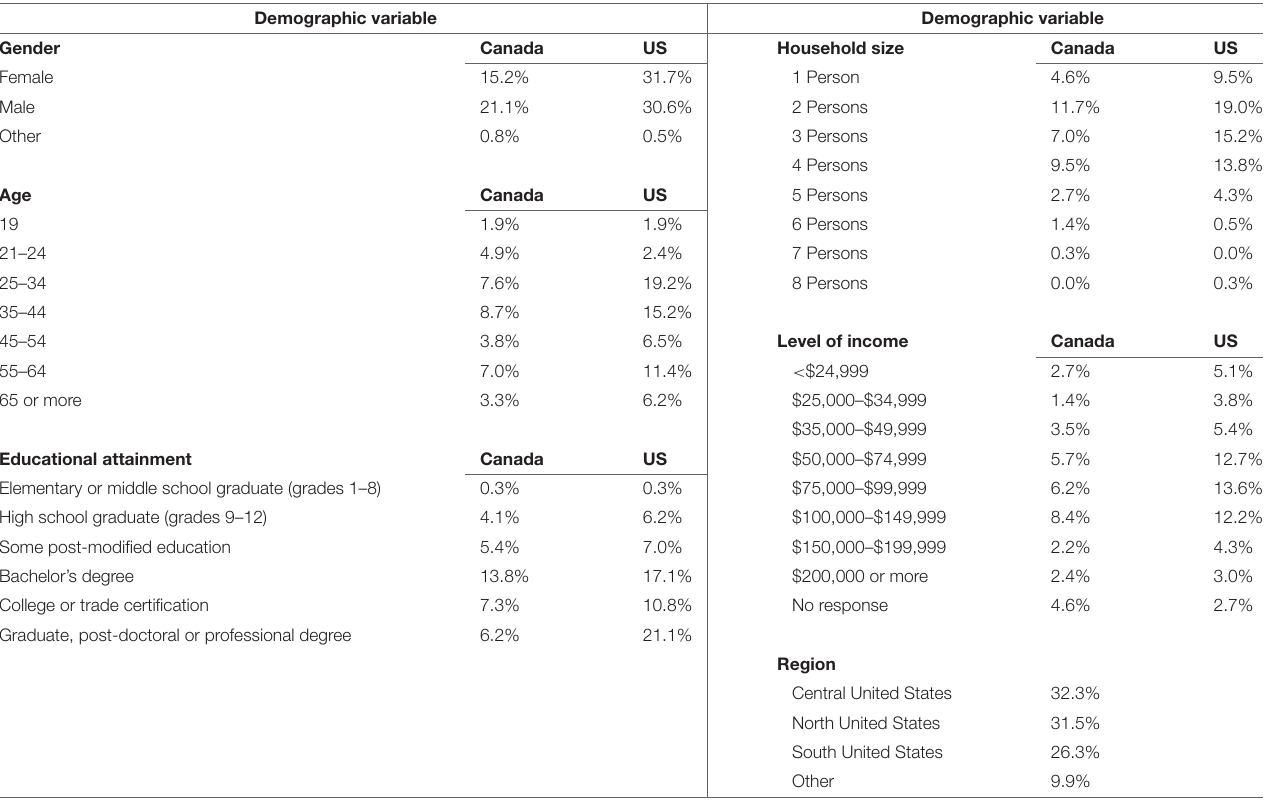
TABLE 2 | Demographics from the monarch enthusiasts’ sample ( n =